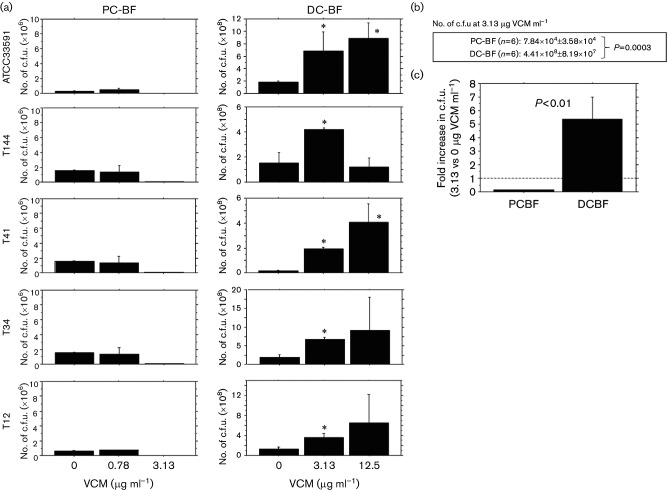
c.f.u. analysis of PC-BF and DC-BF formed by different MRSA 24 h after VCM exposure. (a) PC-BF and DC-BF formed by a MRSA strain (ATCC 33591) and four clinical MRSA isolates were incubated for 24 h with different concentrations of VCM. c.f.u. values for PC-BF (left panels) and DC-BF (right panels) are shown. The data shown are mean values ± se. *, P<0.05. (b) Comparison of c.f.u. between PC-BF and DC-BF using six different MRSA. (c) Comparison of the rate of c.f.u. increase upon VCM exposure (3.13 vs 0 µg VCM ml−1) between PC-BF and DC-BF using six different MRSA.